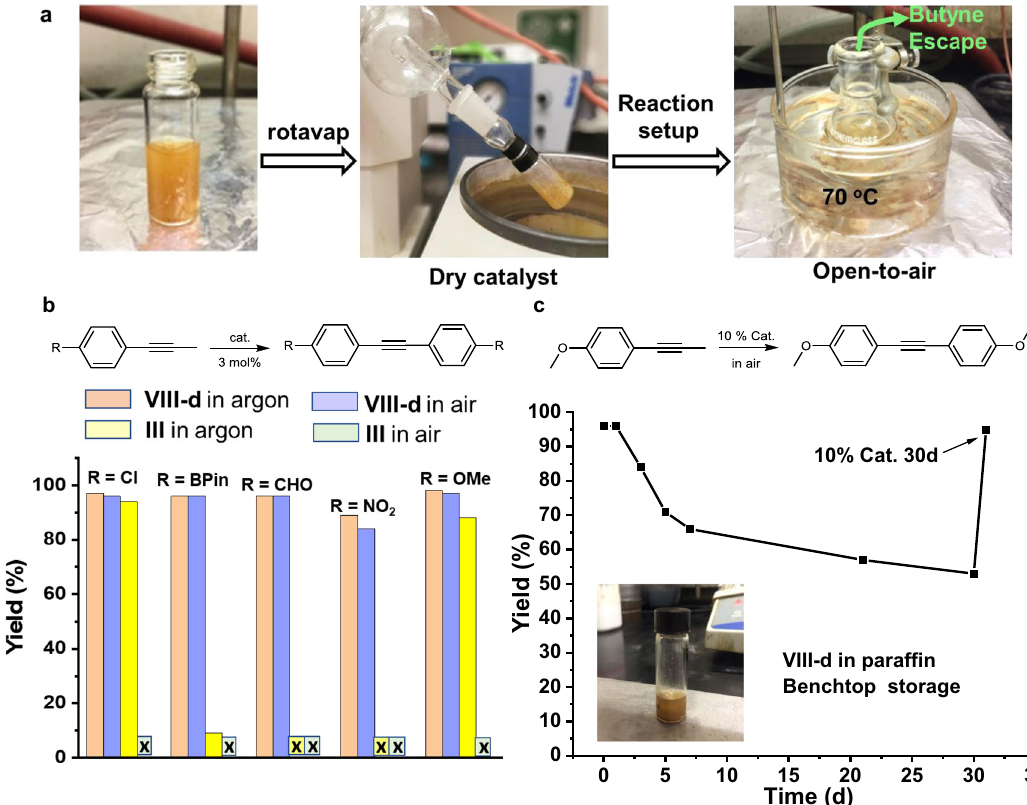
Fig. 5 Catalysis in air. a Open-air alkyne metathesis using catalyst VIII-d . The alkyne metathesis was performed in an open fl ask at 70 °C in the absence of molecular sieves. The activated catalyst was concentrated to dryness using a rotavap. The whole process took approximately 40 min. b Comparison of the catalytic activities of VIII-d and III in air and argon. Conditions for VIII-d in open air: 0.1 mmol substrate, 0.003 mmol catalyst (3 mol%), 3 mL CCl 4 , 70 °C, 30 min; Conditions for VIII-d in argon: 0.1 mmol substrate, 0.003 mmol catalyst (3 mol%), 3 mL CCl 4 , 150 mg MS 5 Å, 70 °C, 30 min. Conditions for III in